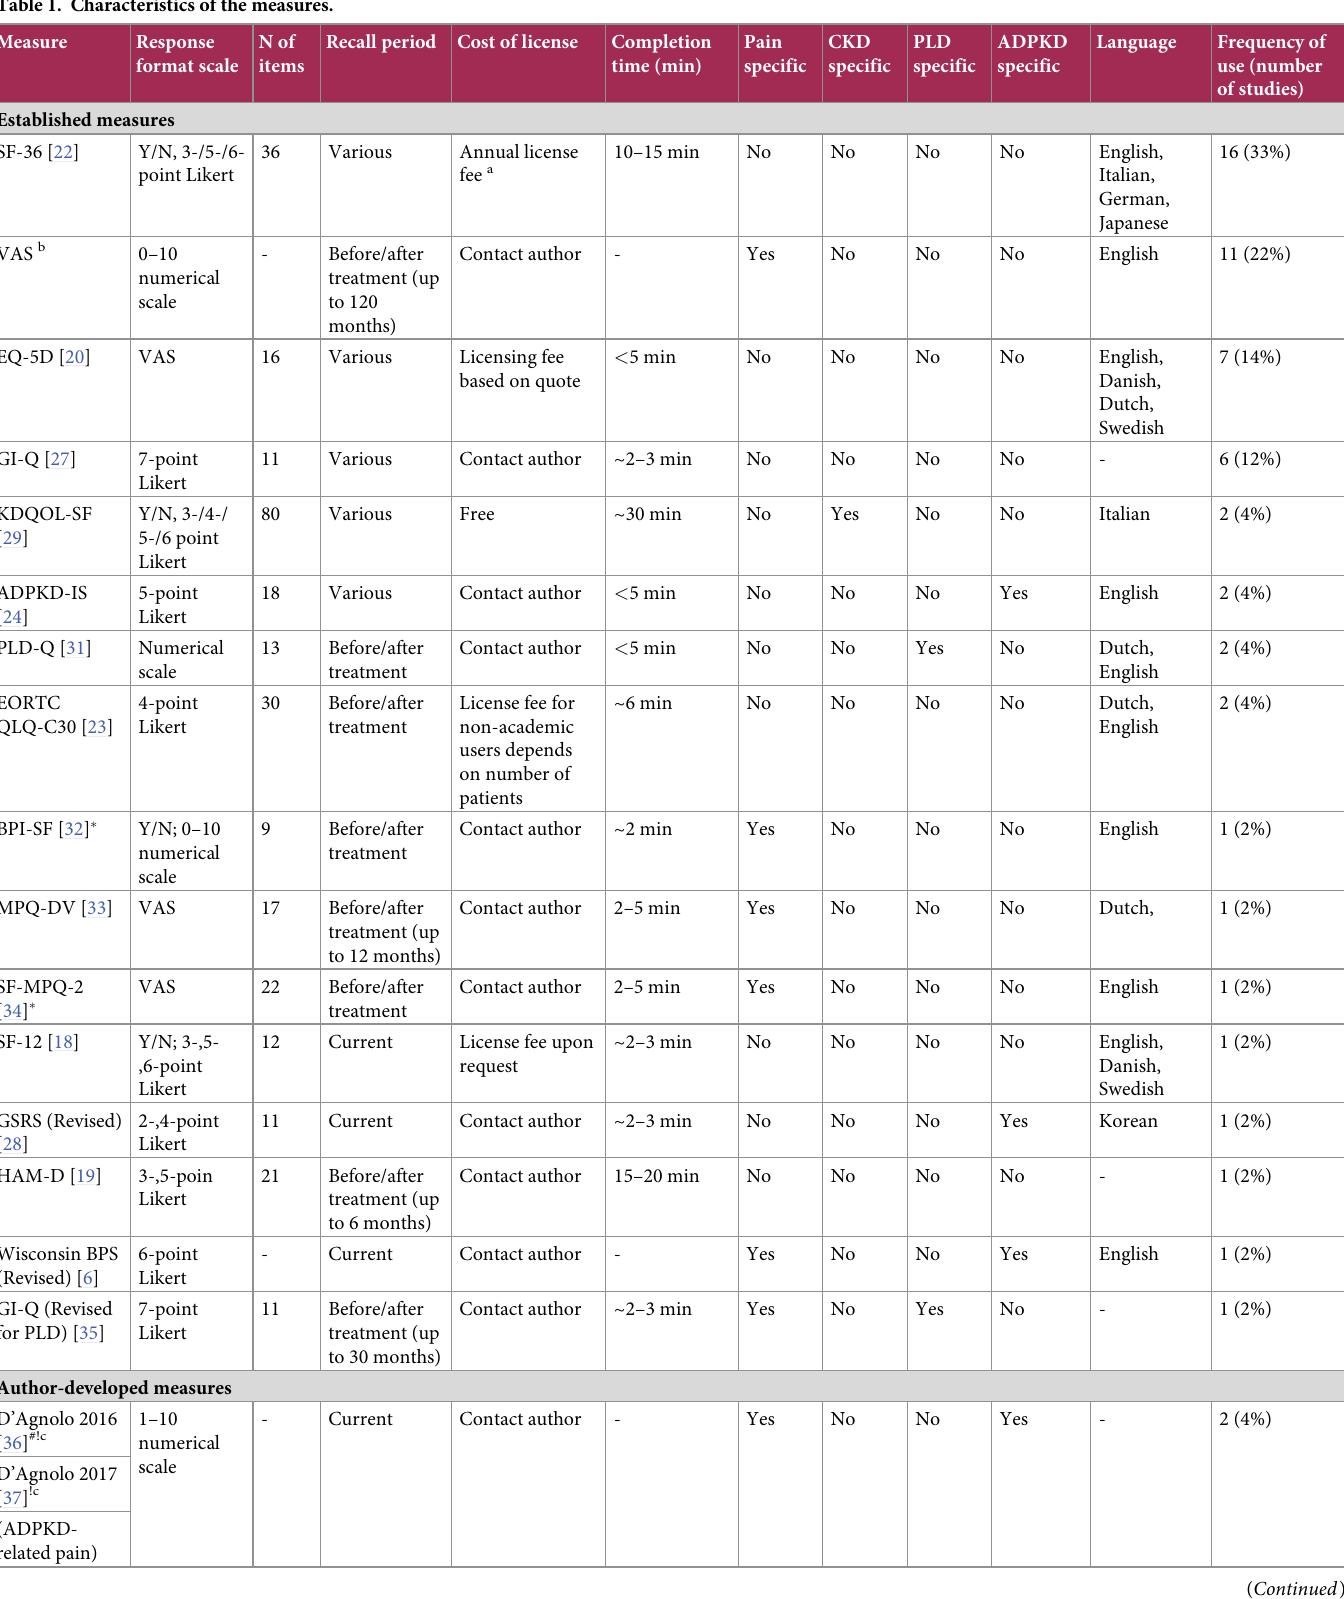
Table 1. Characteristics of the